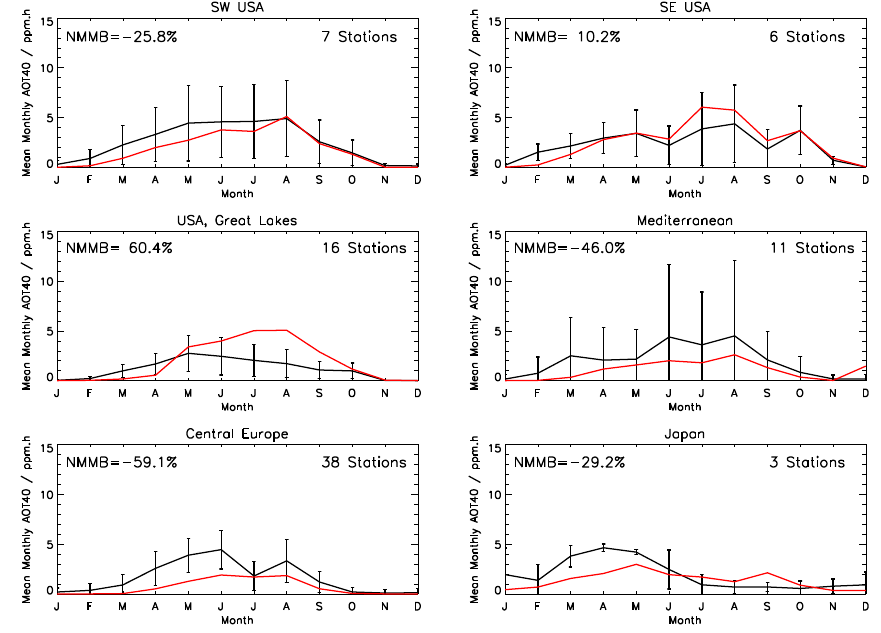
Fig. 5. As Figure 3, but for the monthly-accumulated AOT40 metric (see main text for definition).